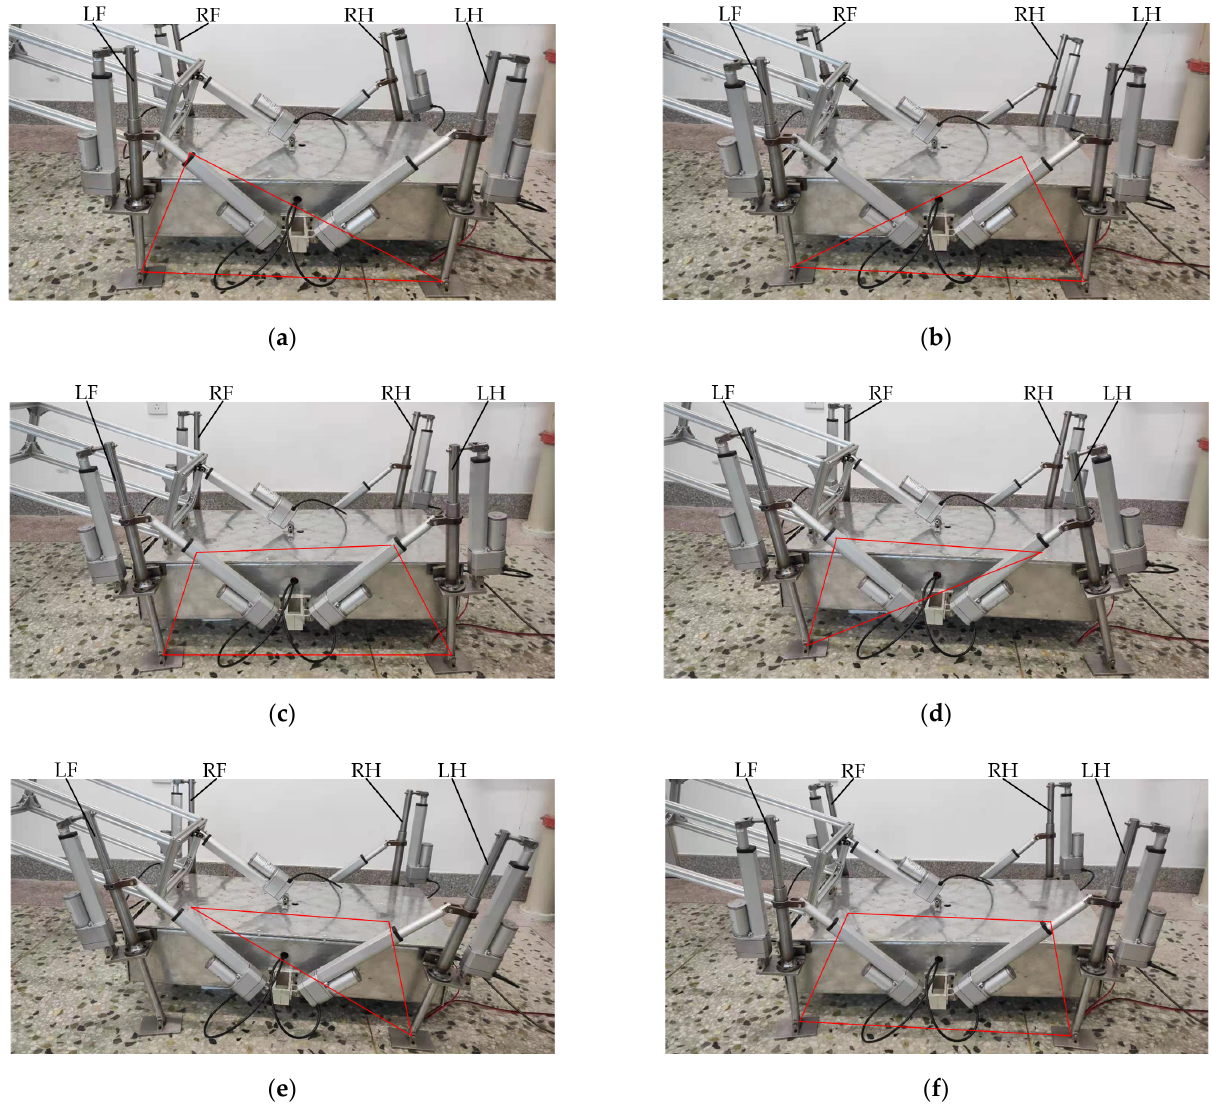
Figure 18. The motion state of the experimental prototype in a cycle in the mixed gait: ( a ) the RH is about to lift, ( b ) the RF is about to lift, ( c ) adjust the center of gravity for the first time, ( d ) the LH is about to lift, ( e ) the LF is about to lift, and ( f ) adjust the center of gravity for the second time.